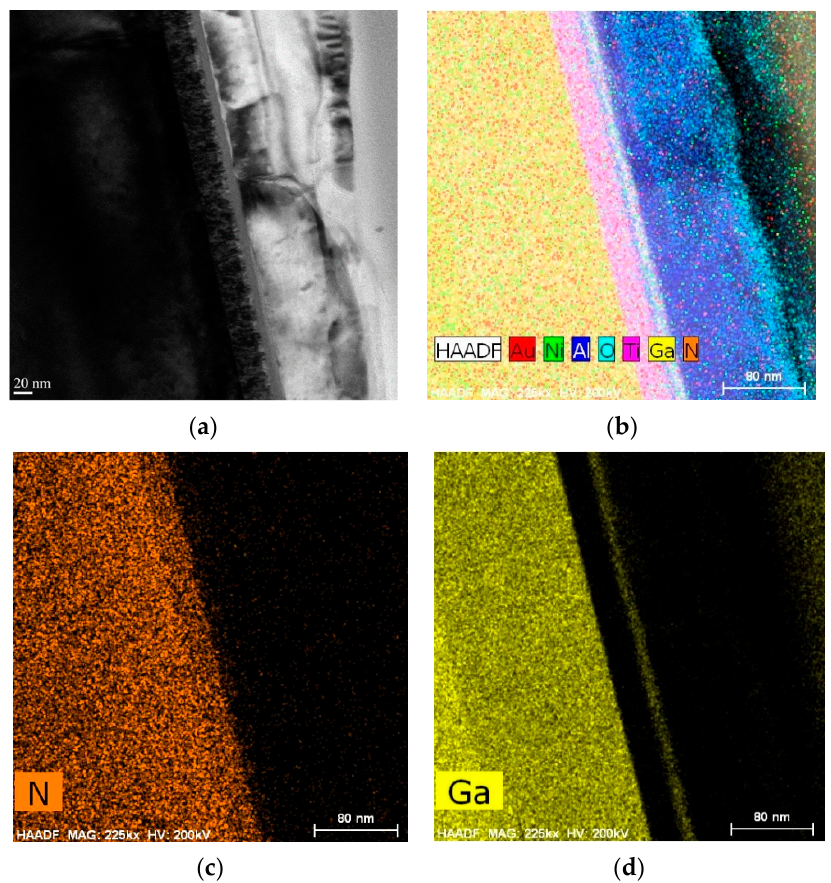
Figure 9. ( a ) TEM and ( b – d ) HAADF STEM images of strongly annealed area 2 in the MSM AlGaN